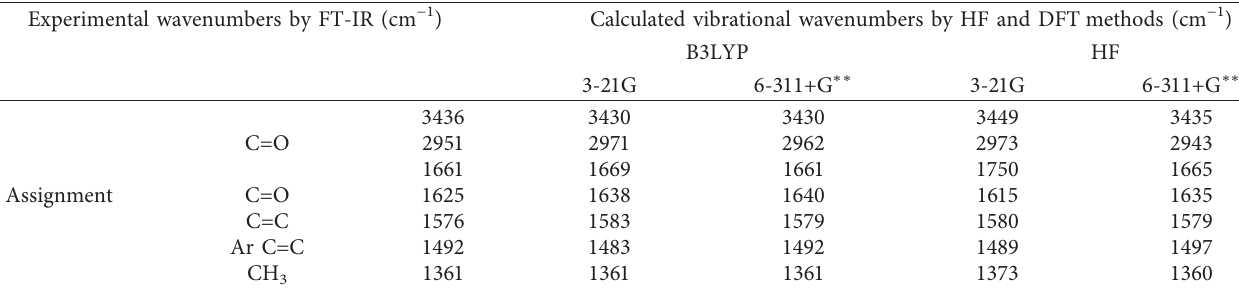
Table 4: The selected experimental and theoretical frequencies of the title compounds using the B3LYP and HF methods for compound (5c) . Experimental wavenumbers by FT-IR (cm − 1 )